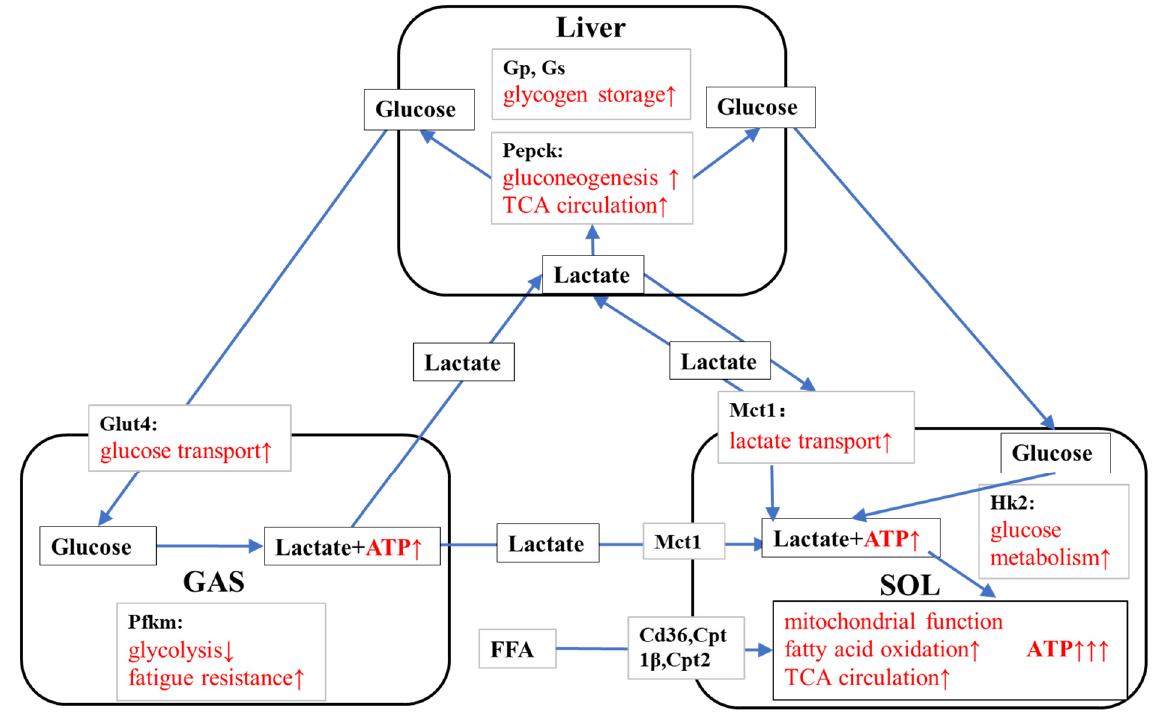
Figure 10. The suggested mechanisms of KPE administration enhancing energy metabolism and substrate utilization. Gs, glycogen synthase; GP, glycogen phosphorylase; Pepck, phosphoenolpyru- vate carboxykinase 1 cytosolic; Pfkm, 6-phosphofructokinase muscle type; MCT1, monocarboxylate transporter 1; Glut4, solute carrier family 2 (facilitated glucose transporter); Hk2, hexokinase 2; Cd36, CD36 molecule; CPT, carnitine palmitoyl transferase; FFA, free fatty acids; GAS, gastrocnemius muscle; SOL, soleus muscle. Arrows, Potential effects of KPE